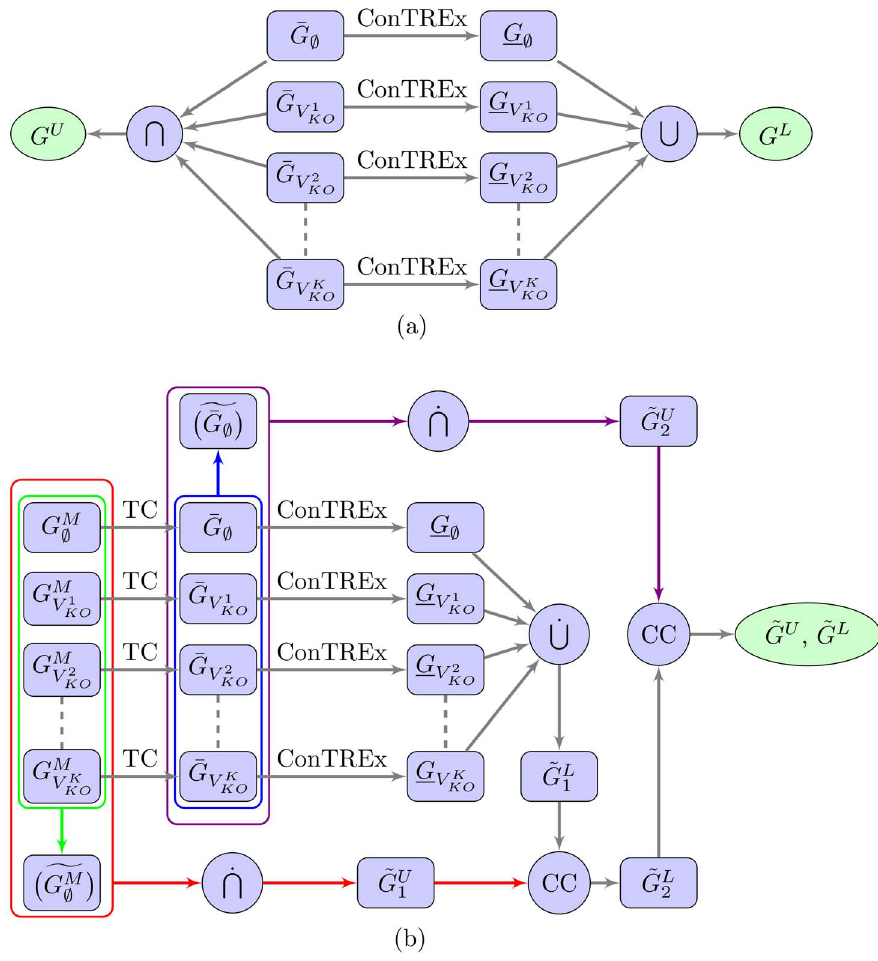
Figure 3. Schematic diagrams of TRaCE with and without error correction. (a) Construction of the lower bound G L and upper bound G U from (cid:2) GG 6 0 and (cid:2) GG V k ’s using TRaCE without error correction. Expression data from gene KO experiments are first converted into accessibility matrices. KO ConTREx is then applied to each accessibility matrix, removing feed-forward edges and edges incident to vertices belonging cycles with more than 2 nodes. The upper bound is constructed by taking the intersection of the accessibility matrices, while the lower bound is constructed by taking the union of the ConTREx outputs. (b) Construction of the lower bound G L and upper bound G U from (cid:2) GG 6 0 and (cid:2) GG V k Expression data from gene KO experiments are converted into accessibility matrices G M